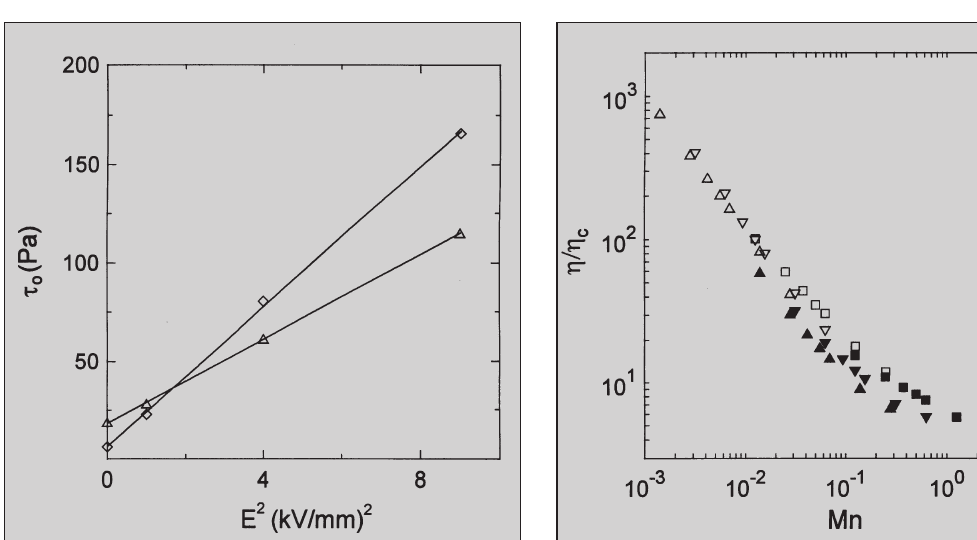
viscosity, η/η c, on the Mason number, Mn, for the suspensions in silicone oils SO 100 (open points) and SO 1000 (solid points) (Field strength (kV/mm): 1 ( „ , ‚